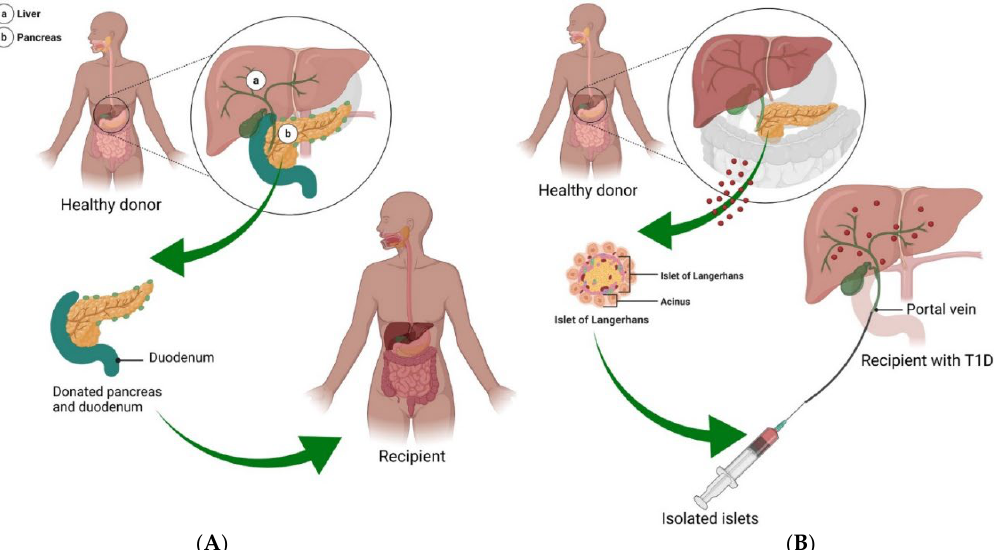
Figure 3. Pancreas and islet cell transplantation. ( A ) In T1DM, many of the islet β -cells die, limiting insulin production and leading to a number of life-long complications. The only near-cure treatment strategy is the transplantation of a pancreas from a healthy donor. In this situation, a pancreas with a small portion of the duodenum attached is inserted into the T1DM patient. With this approach, recipients are able to achieve up to 5 years of insulin independence. ( B ) Considered an experimental procedure, delivery of islet cells to T1DM patients offers a less invasive and lower risk treatment option, in which islet cells from 1 to 3 healthy donors are isolated and delivered to the pancreas via the portal